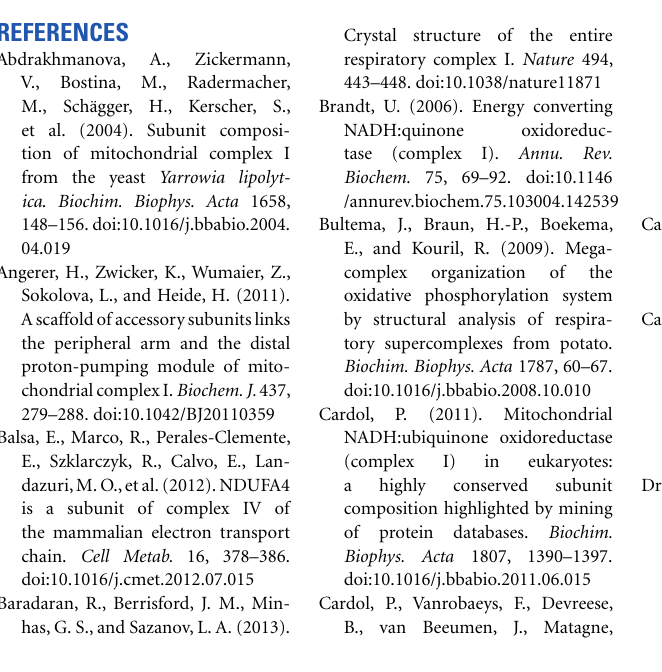
Table S2 | Protein table of complex I subunits in leaves of Arabidopsis thaliana . Table S3 | Protein table of complex I subunits in roots of Arabidopsis thaliana